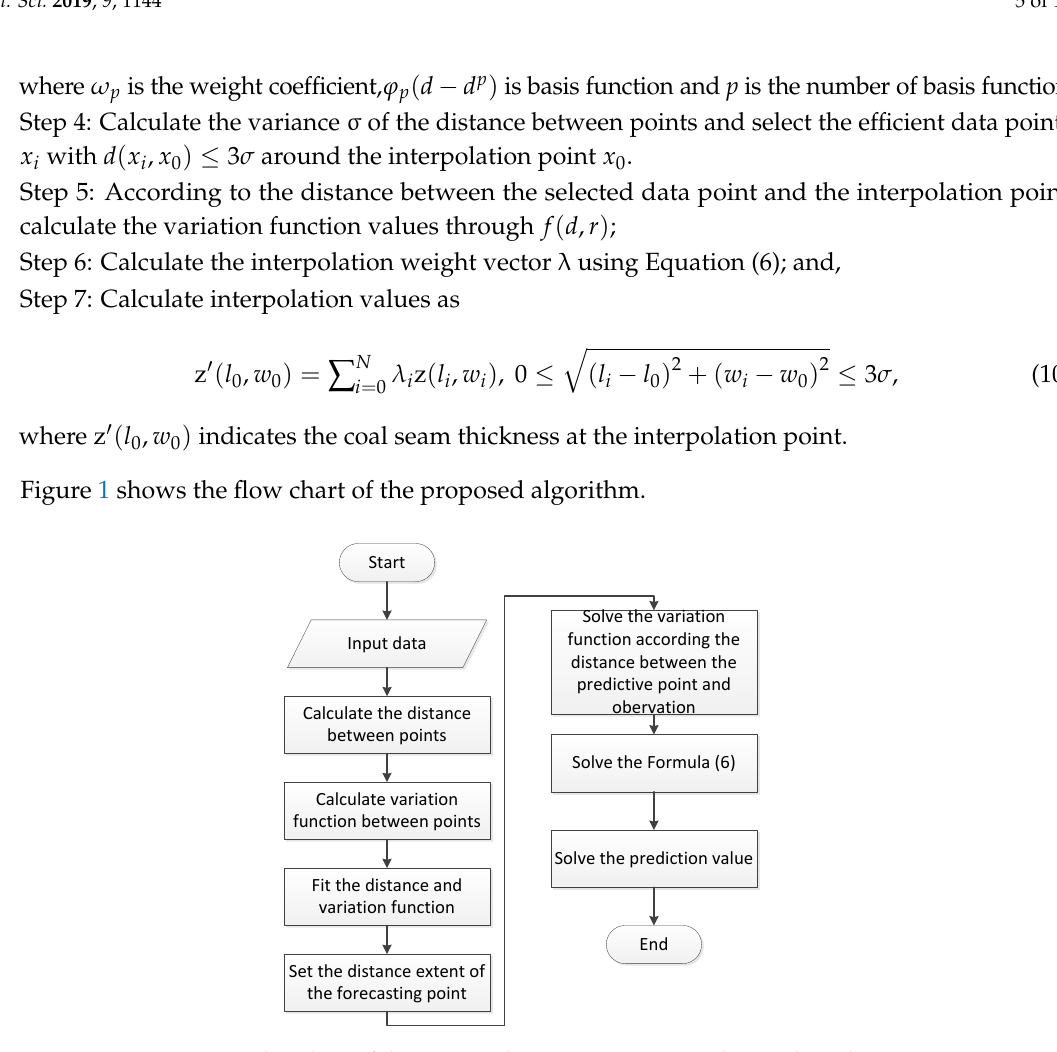
Figure 1. Flowchart of the proposed RBF-Kriging interpolation algorithm.